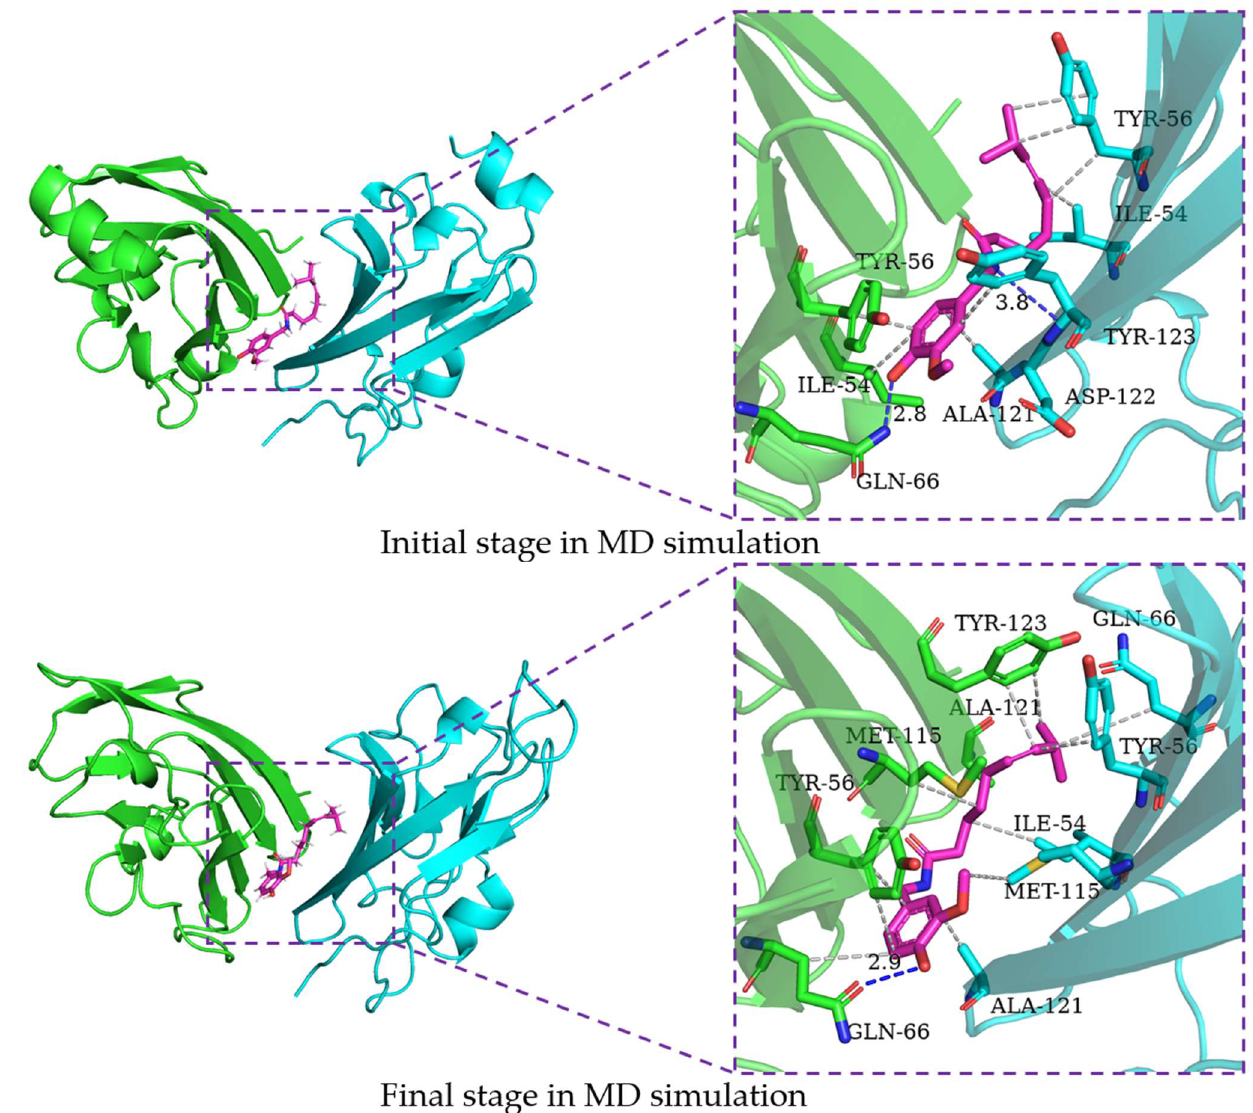
Figure 7. The interaction of zucapsaicin and residues of the binding site at 0 ns and 200 ns, the key residues on (A)PD-L1 and (B)PD-L1 are shown as green and cyan sticks, respectively, while the ligands are shown as pink sticks. Hydrophobic interactions, H-bonds and Π-stacking are shown as gray, blue and yellow dashes, respectively.